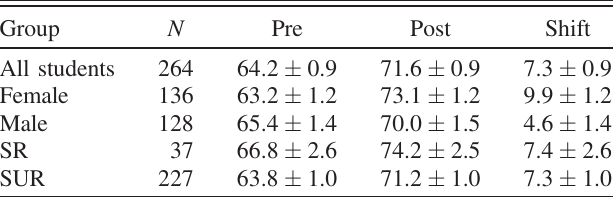
TABLE II. Average precourse, postcourse, and shifts in per- centage favorable responses (cid:3) standard error of the